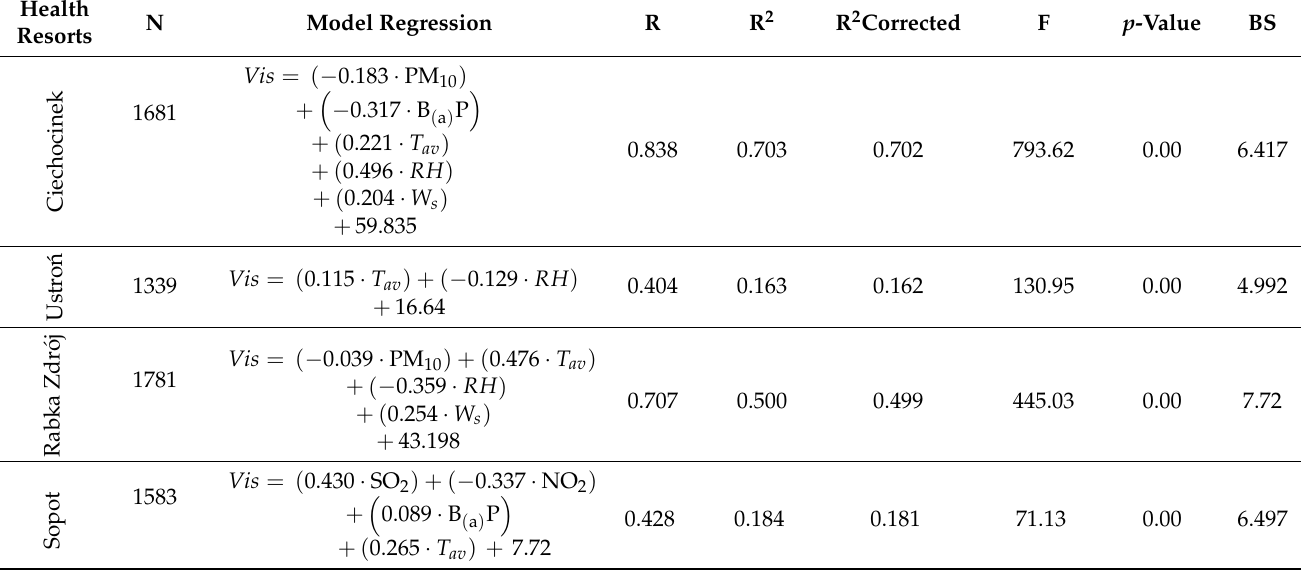
Table 8. Values of person correlation coefficient (R) and multiple determination factor (R 2 ) between air pollution including meteorological conditions and visibility from four health resorts in